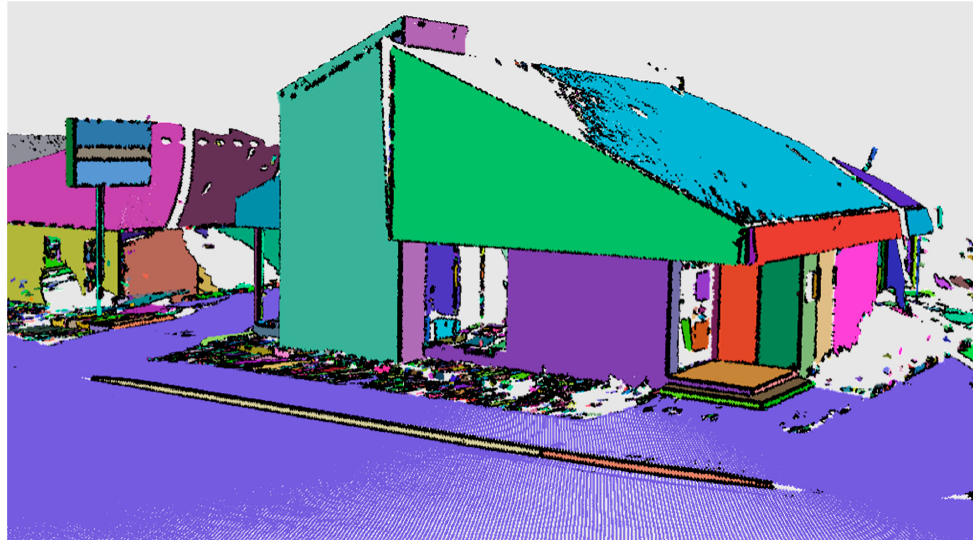
Figure 3. An example of Mo-norvana segmentation results where the black points are the edge points detected while each color represents a segment of smooth surface